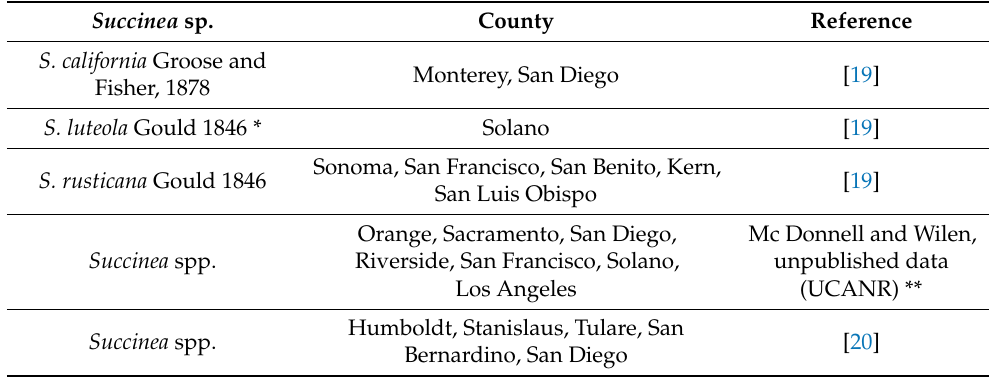
Table 1. The species of Succinea found in California and the counties they were collected from. Succinea